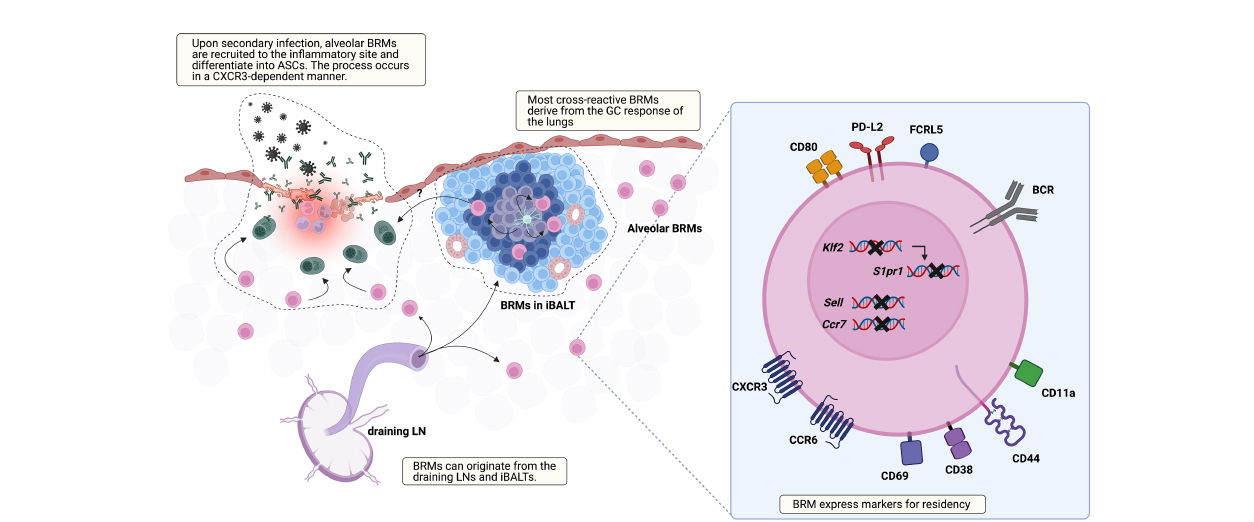
FIGURE 1 | Overview of lung BRM. BRMs are established in sites exposed to local antigens. It is likely that early lung BRMs derive from the draining LNs and late cross- reactive BRMs originate from lung GC reactions, which occur in iBALTs. Lung BRMs can be located within the iBALTs or reside throughout the lung parenchyma in close contact with alveoli, independent of iBALTs. Upon secondary infection, alveolar BRMs migrate to the in fl ammation foci, which is mediated by alveolar macrophages, and differentiate into PCs. The corresponding functional role of BRMs in iBALT has not been reported. The illustration of the BRM shows most of the surface molecules described in published studies so far. The upregulation of CD69, which reduces surface expression of S1PR1, is consistently reported. Klf2 is a transcription factor that mediates S1PR1 expression. The expression of genes encoding the LN homing molecules Sell and Ccr7 is downregulated. CXCR3 and CCR6 facilitate recruitment and/ or retention of BRM in the lung. In addition, CCR6 is related to BRM differentiation into PCs in recall response. The upregulation of CD44 and CD11a in BRM is also reported. These may serve as an adhesion molecule for BRMs, but their functional role needs to be validated. Compared with circulating MBCs, lung BRMs have been shown to express higher levels of FCRL5, CD80, and